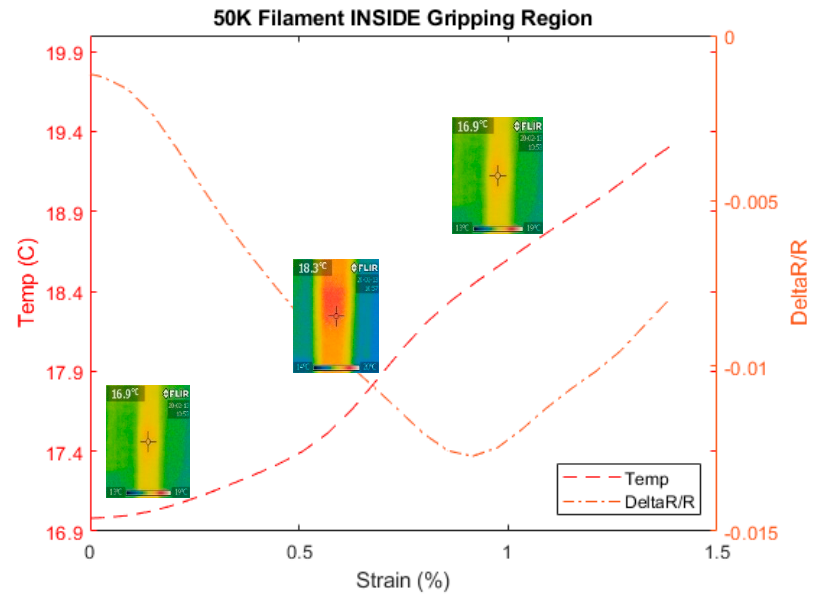
Figure 18. Temperature and relative resistance variation for the 50 K carbon fiber.